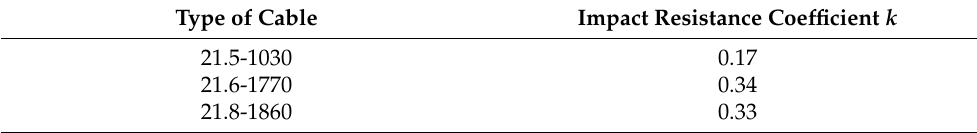
Table 3. Impact resistance coefficient of different